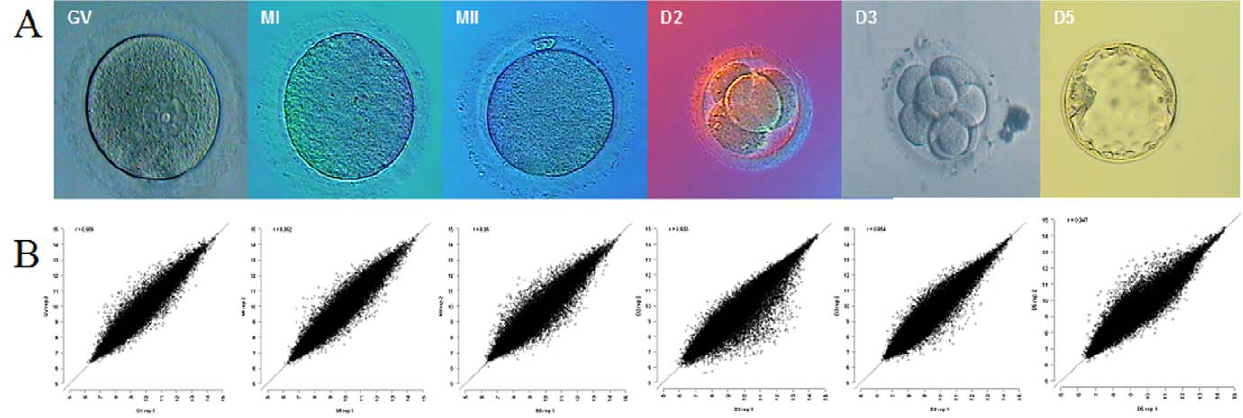
Figure 4. Morphology of human oocytes and embryos used in the study. B. Correlations between biological duplicates.